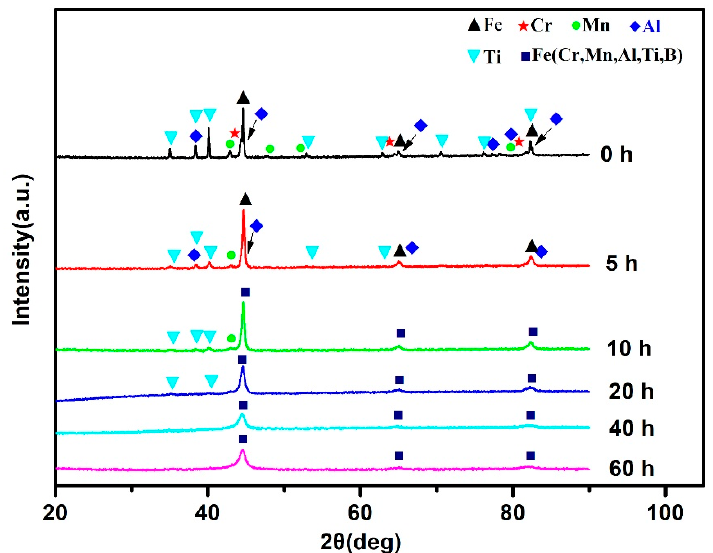
Figure 2. XRD patterns for 25 vol.%TiB 2 /Fe-15Cr-10Mn-5Al powders after different time of ball milling.